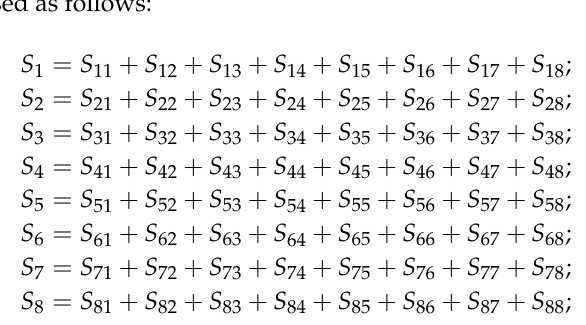
Figure 12. The measured ECC ( a ) between element 1 and other elements; ( b ) between the rest of the adjacent elements.